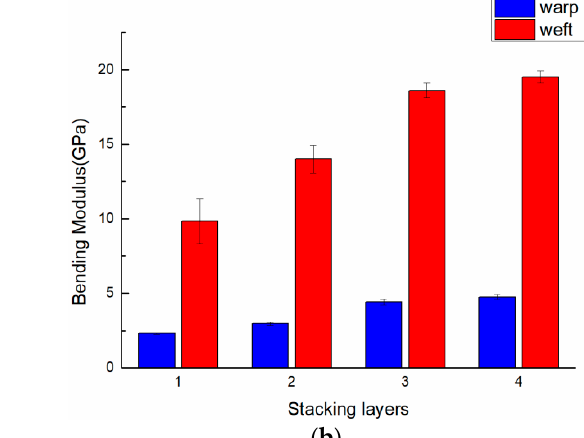
Figure 6. Comparison of the bending properties of materials with different stacking layers. ( a ) Bending strength. ( b ) Bending stiffness.